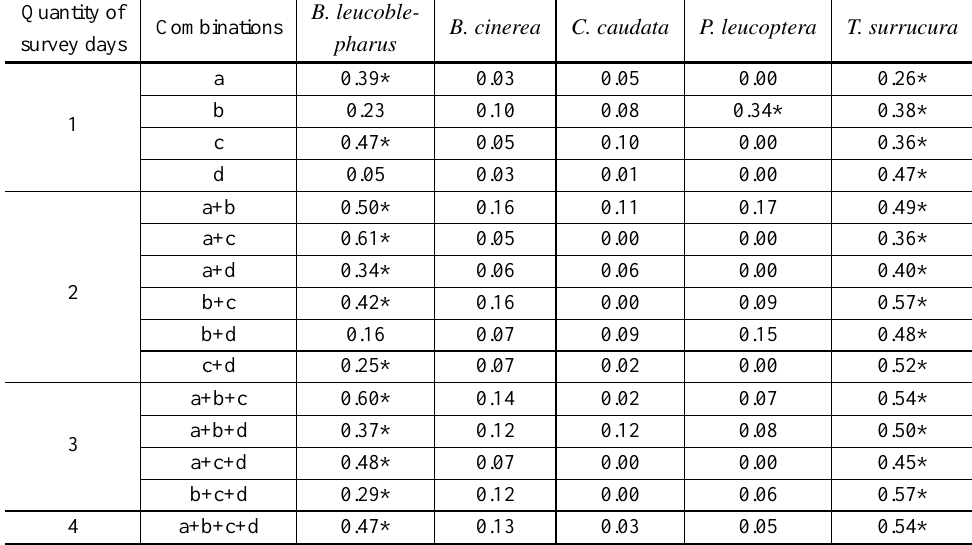
Pearson correlations coefficients (r 2 ) between the efficiency of the playback and the abundance index values (IPA) for all species and all possible combinations of survey days (a, b, c, d). Quantity of